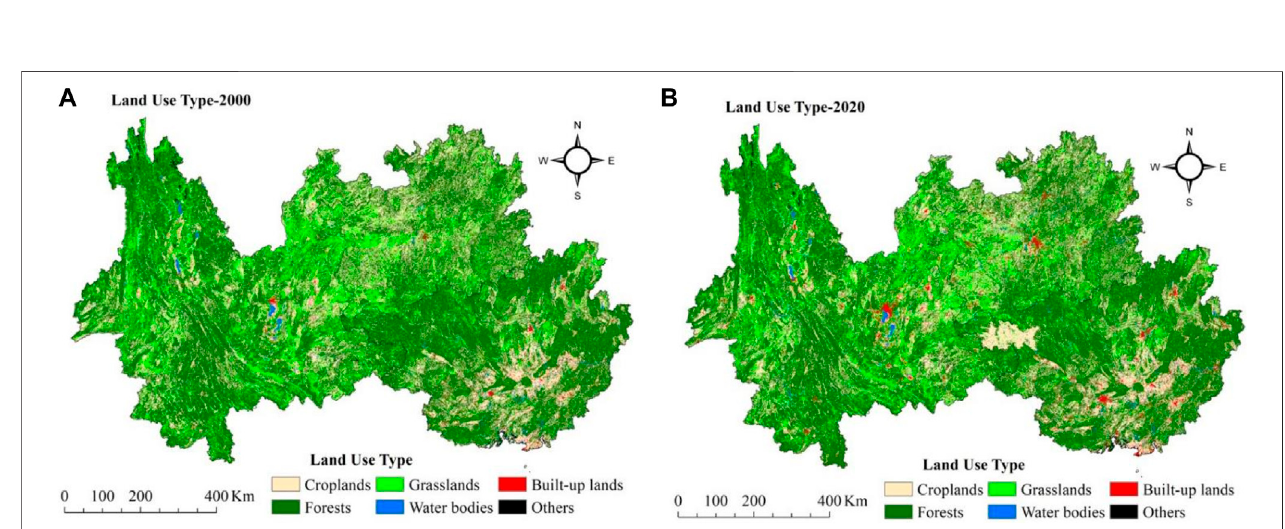
FIGURE 12 | Spatial transformation variation map of land use type in the three karst provinces of southwest China between 2000 and 2020 (km 2 ).